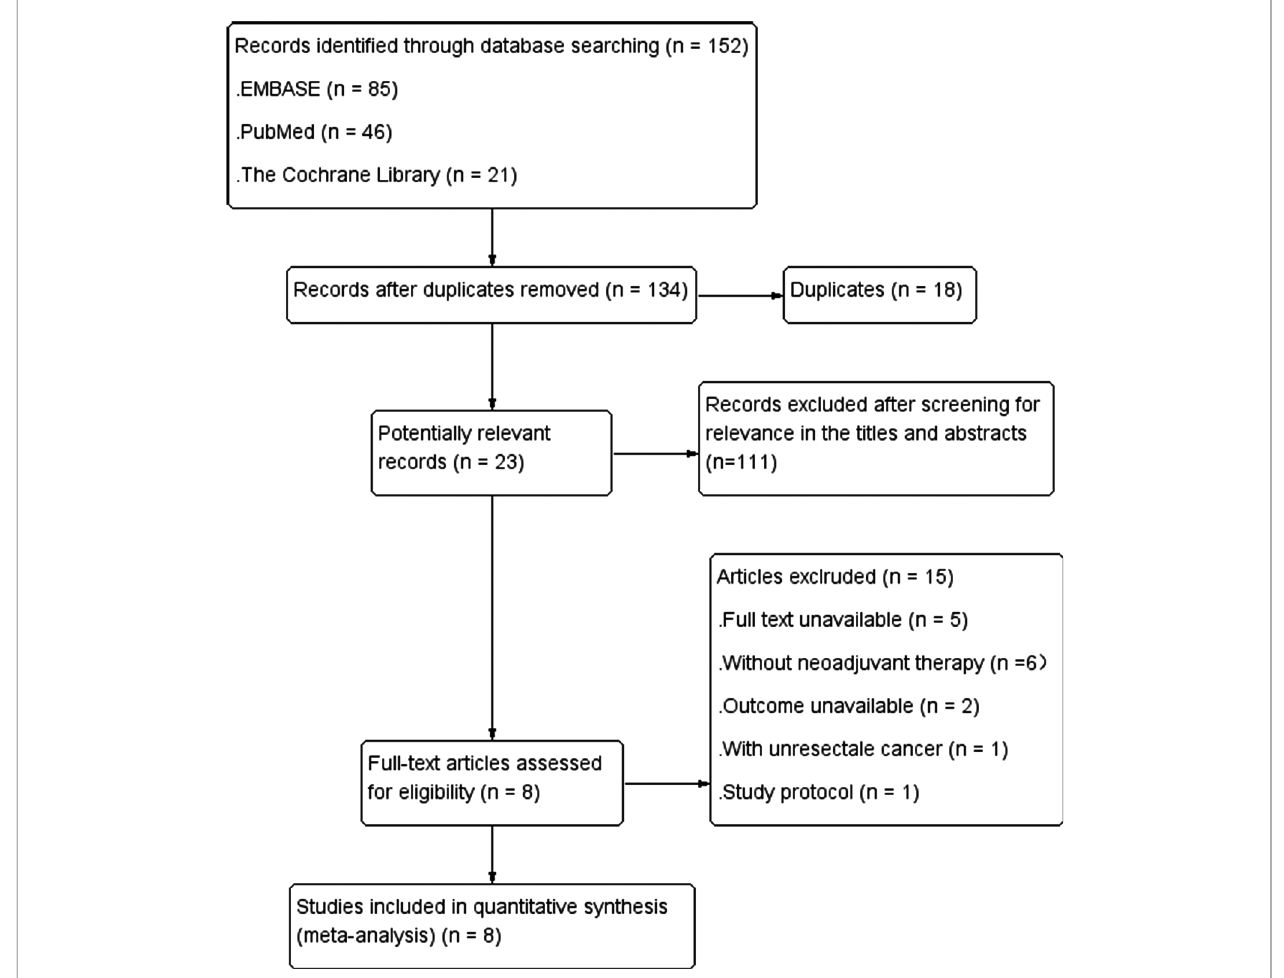
FIGURE 1 | Flow diagram of the process of including and excluding studies for this